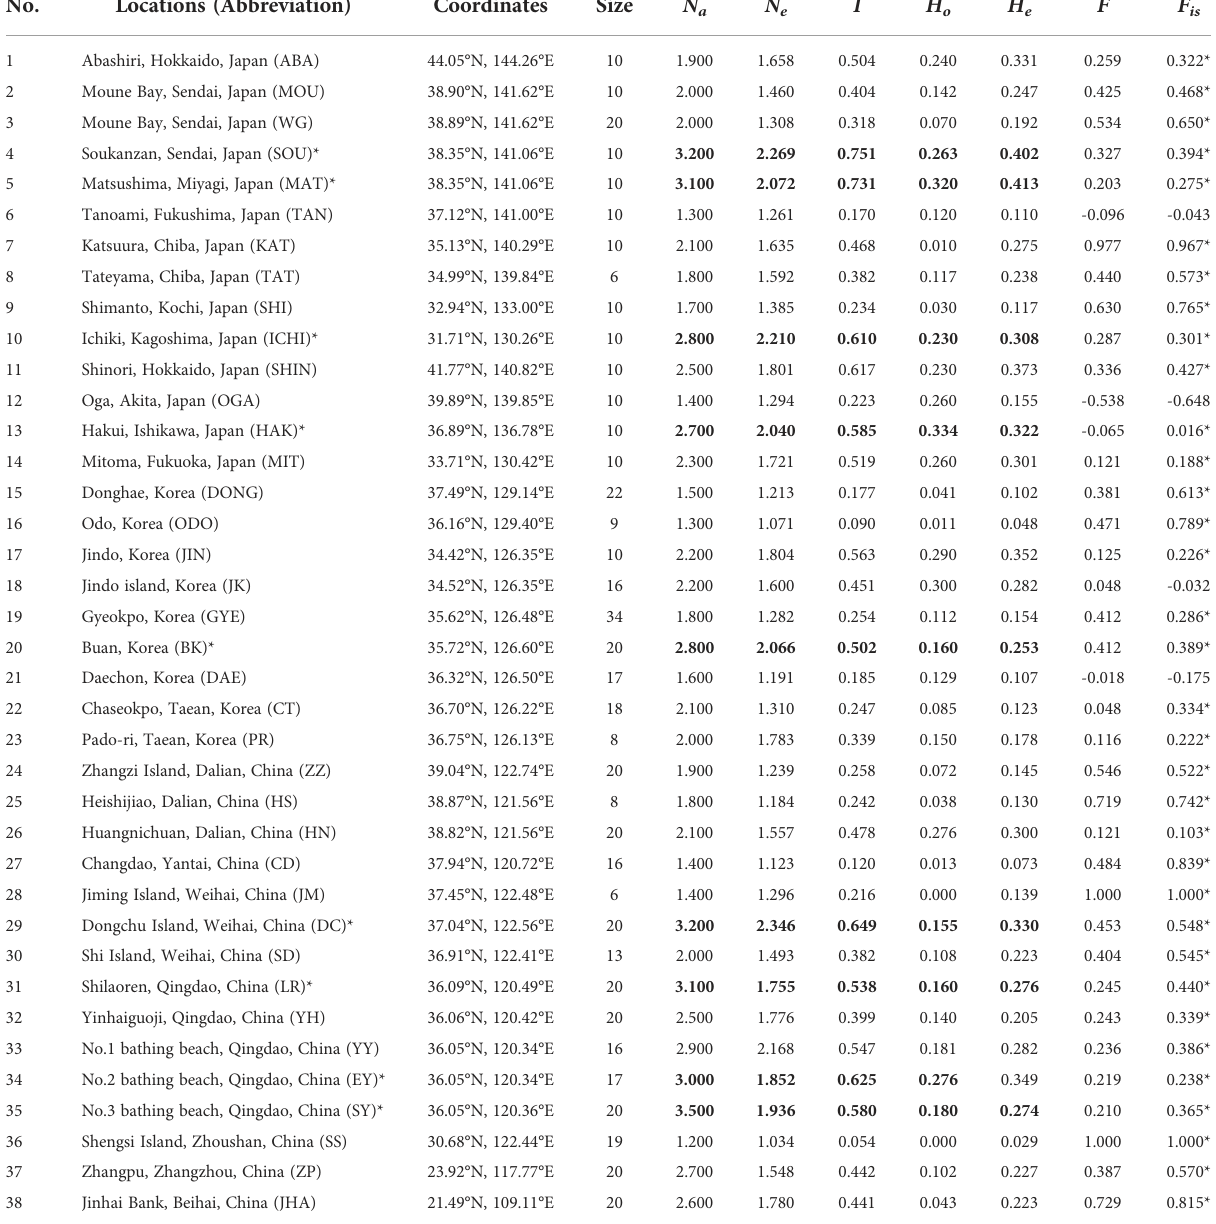
TABLE 1 Sampling information of G. vermiculophylla in the northwest Paci fi c and genetic diversity indices. No. Locations